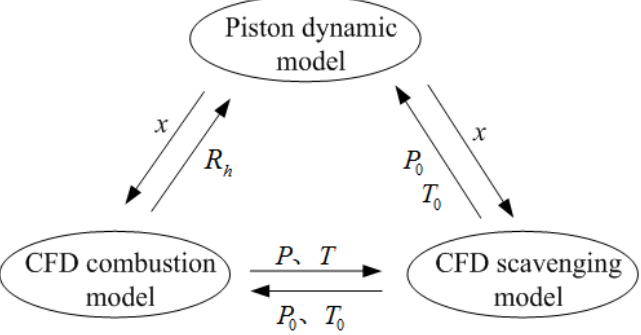
Figure 2. The numerical iterative method for FPGLG combustion process calculation.